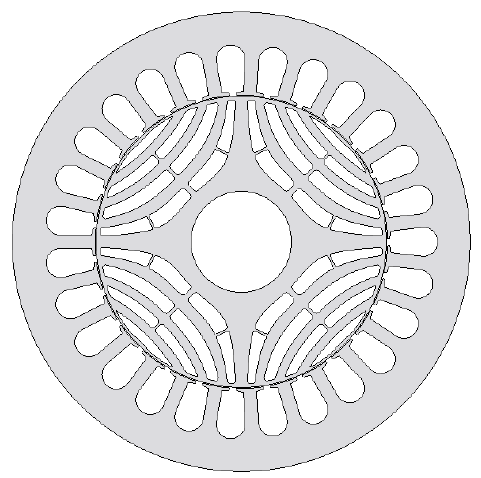
Figure 7. Cross section of SynRM’s final topology.